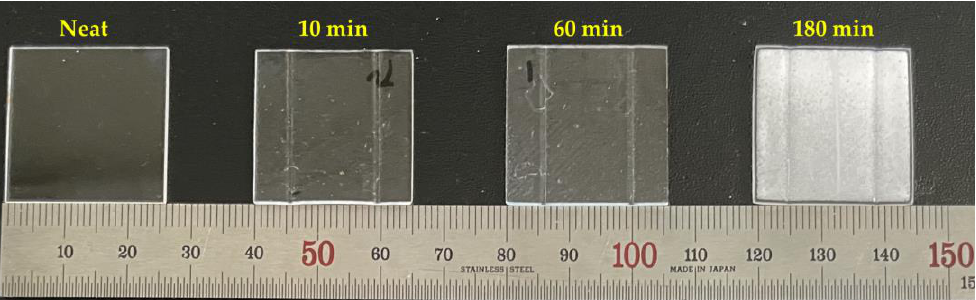
Figure 7. Image of the specimen after overall processing as a function of saturation time.